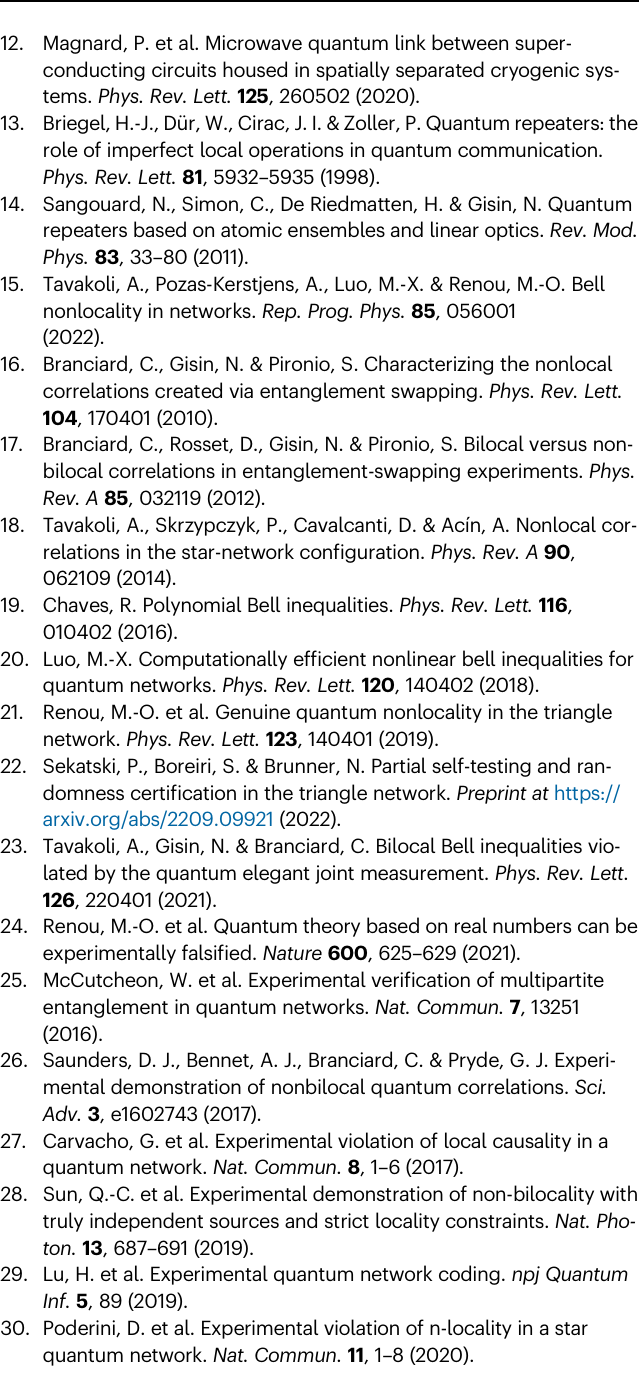
Fig. 7 | Tomographic results of the GHZ projector. The a real part and b imaginary part of the reconstructed matrix of the GHZ